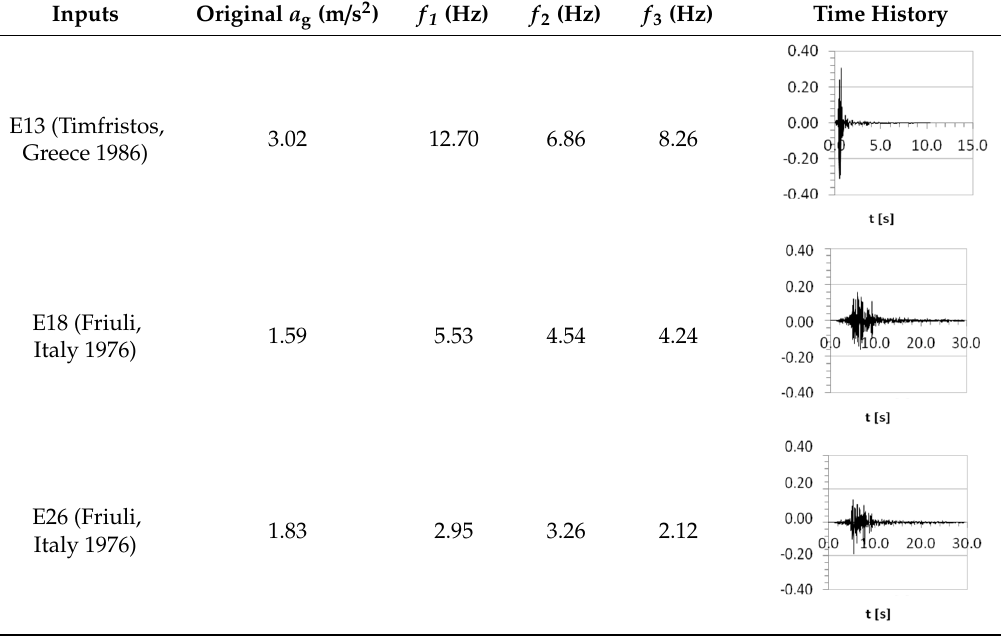
Table 2. The input motions adopted.